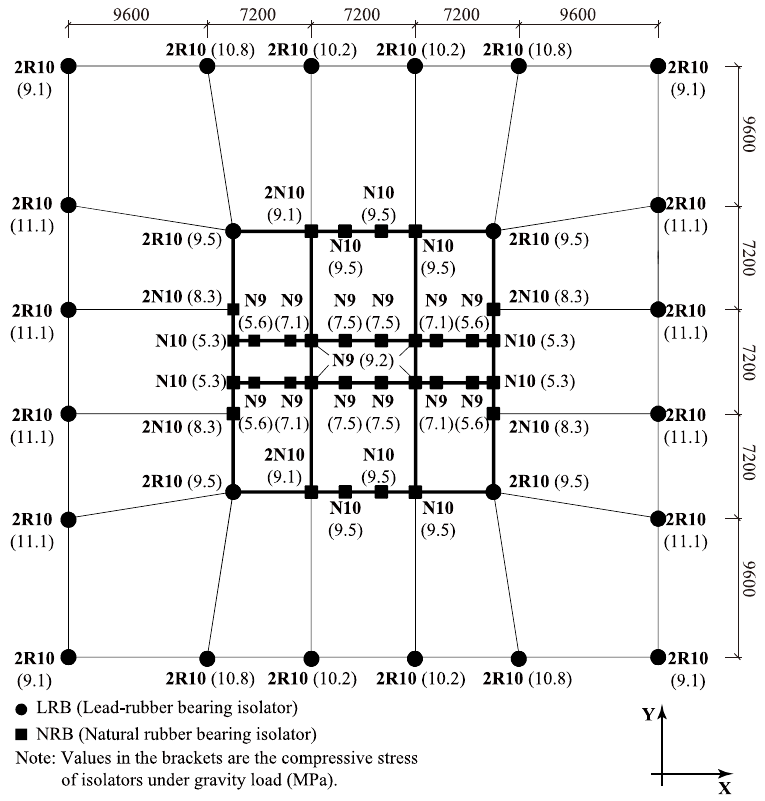
Figure 14. Compressive stress of isolators under gravity load